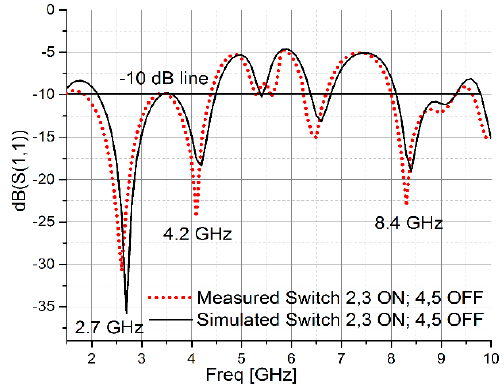
Figure 15. Measured and simulated S 11 for switches 2 and 3 ON, switches 4 and 5 OFF.